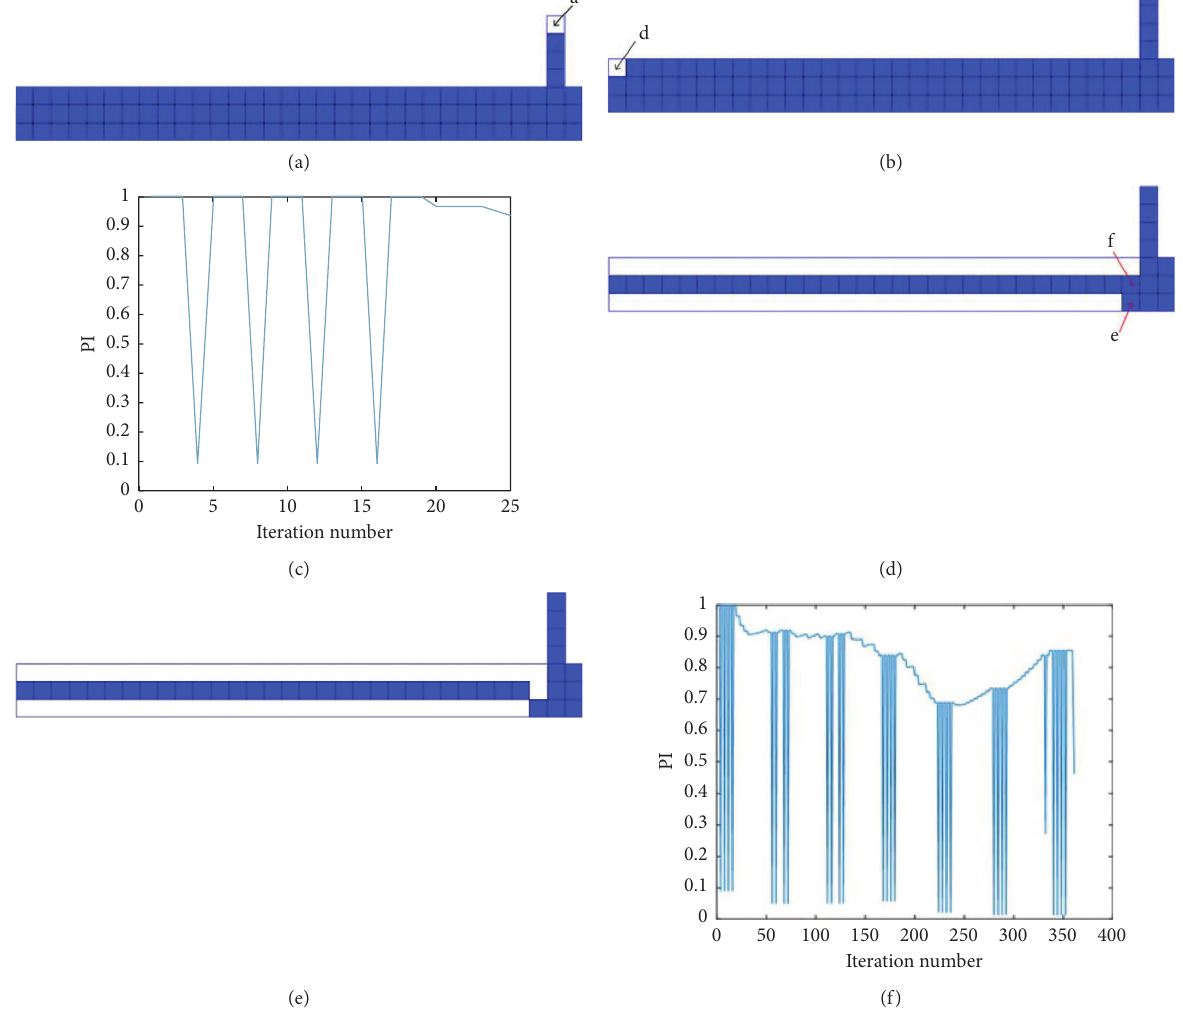
Figure 3: IGESO optimal design on Zhou-Rozvany counterexample: (a) topology after 4 iterations, (b) topology after 20 iterations, (c) PI curve of 24 iterations, (d) topology for 59% volume reduction, (e) topology for 60% volume reduction, and (f) PI curve of the whole